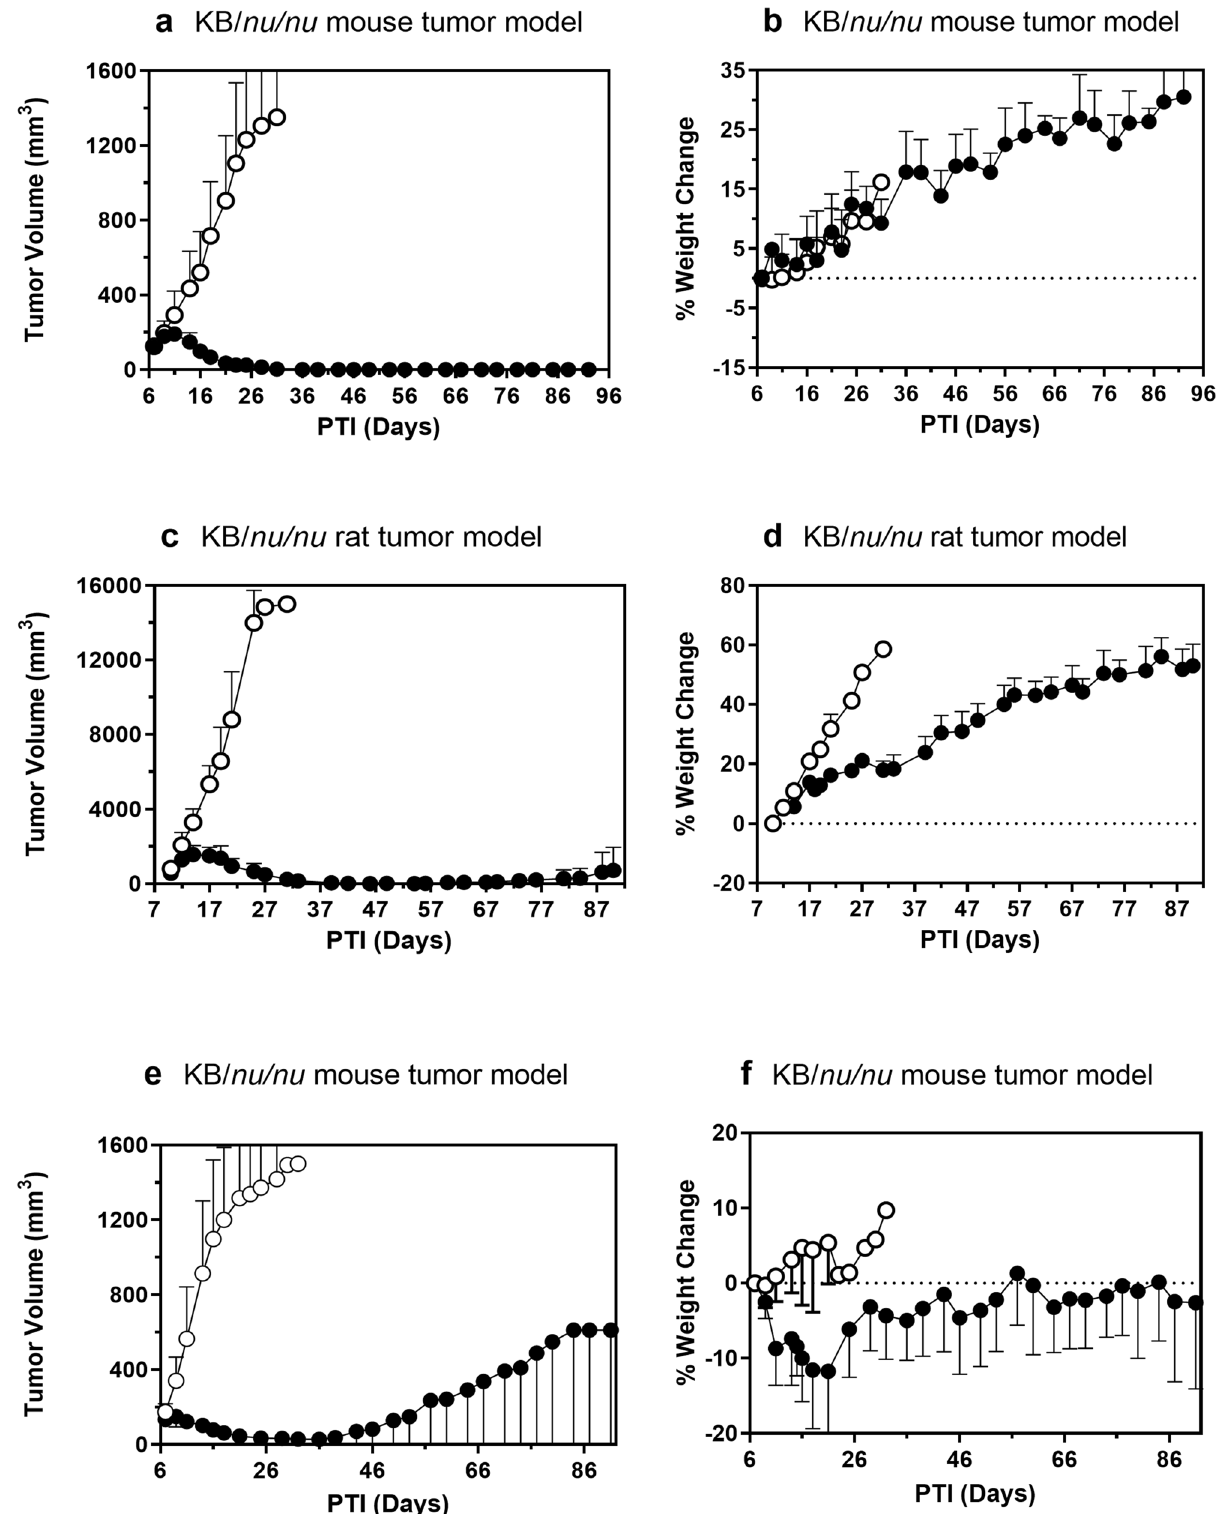
Figure 3. Antitumor ( a , c , e ) and weight change ( b , d , f ) effects of EC2629 ( a , b , c , d ) and SJG-136 ( e , f ) on FR expressing KB tumor nu/nu mice ( a , b , e , f ) and rat ( c , d ) models. KB tumor cells were inoculated subcutaneously into nu/nu mice (1 × 10 6 cells) and rats (5 × 10 6 cells) and therapy started on randomized animals with tumors in the 111–168 mm 3 (mice; n = 5) and 411–704 mm 3 (rats; n = 3) range. open circle, untreated controls; filled circle, EC2629, 0.3 µmol/kg ( a , b ) or 0.15 µmol/kg ( c , d ) or SJG-136, 0.3 mg/kg ( e , f ) in 0.05% Tween-80) SIW × 2 weeks. Each curve shows the average volume of 3–5 tumors/animals; bars,